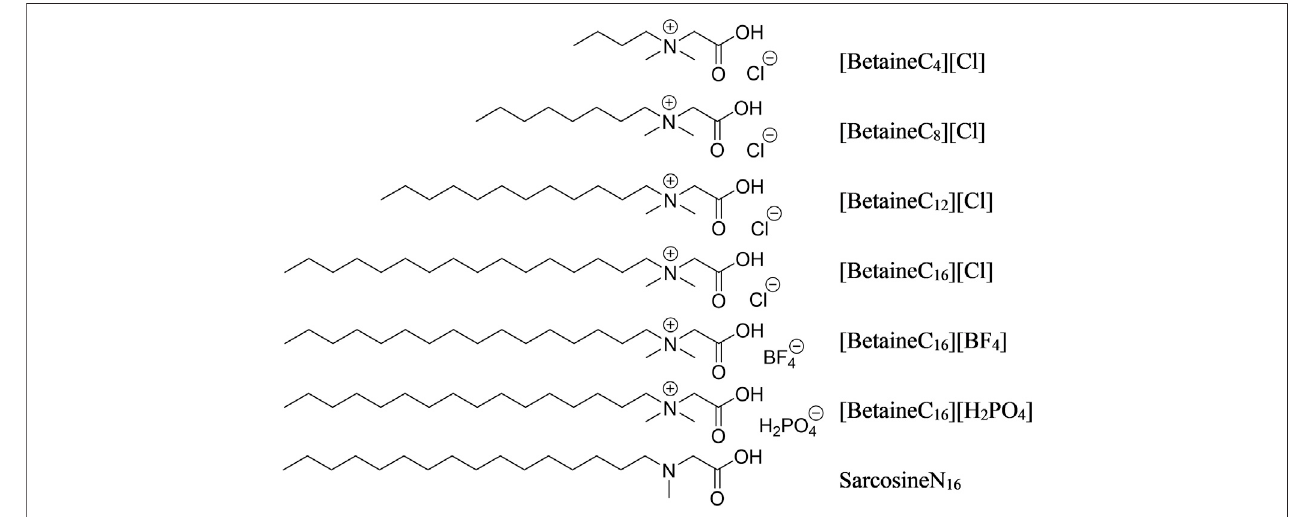
FIGURE 1 | Structure of the seven modi fi